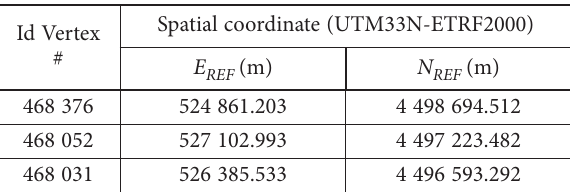
Table 2. Coordinates of the check points